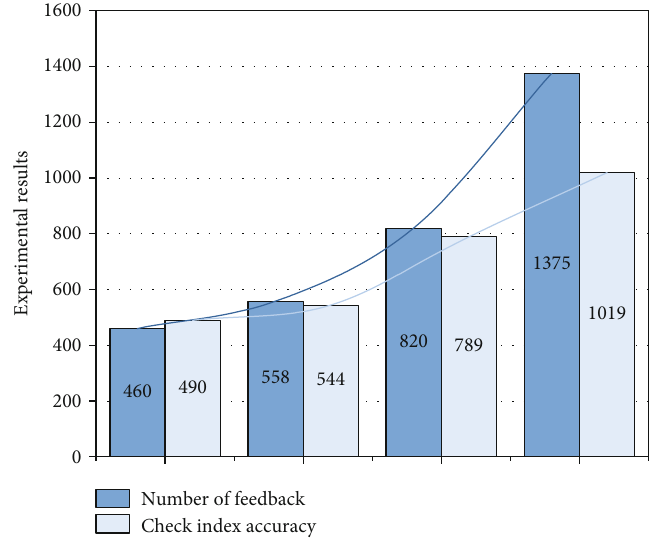
Figure 9: Graph of experimental results of two